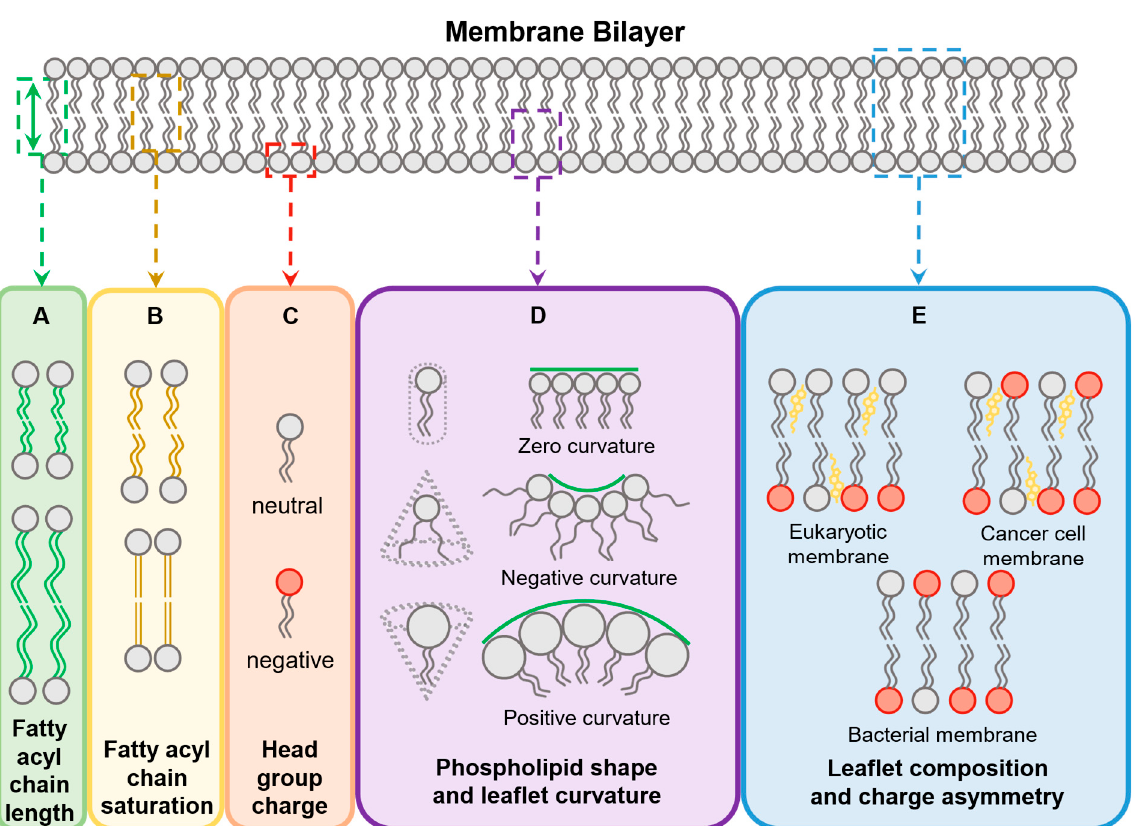
Figure 2. Membrane characteristics which influence penetration. Fatty acyl chain length ( A ) and satu- ration ( B ), as well as head group charge ( C ) affect the interaction and degree of disruption. The shape of phospholipids can also affect curvature ( D ). Leaflet composition and differences between inner and outer leaflets ( E ) also influence which membrane active peptides can penetrate a specific membrane.